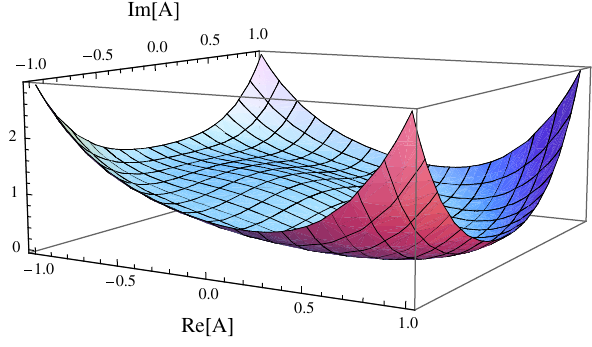
¯ A − 2 J V asafunctionofRe ( A )